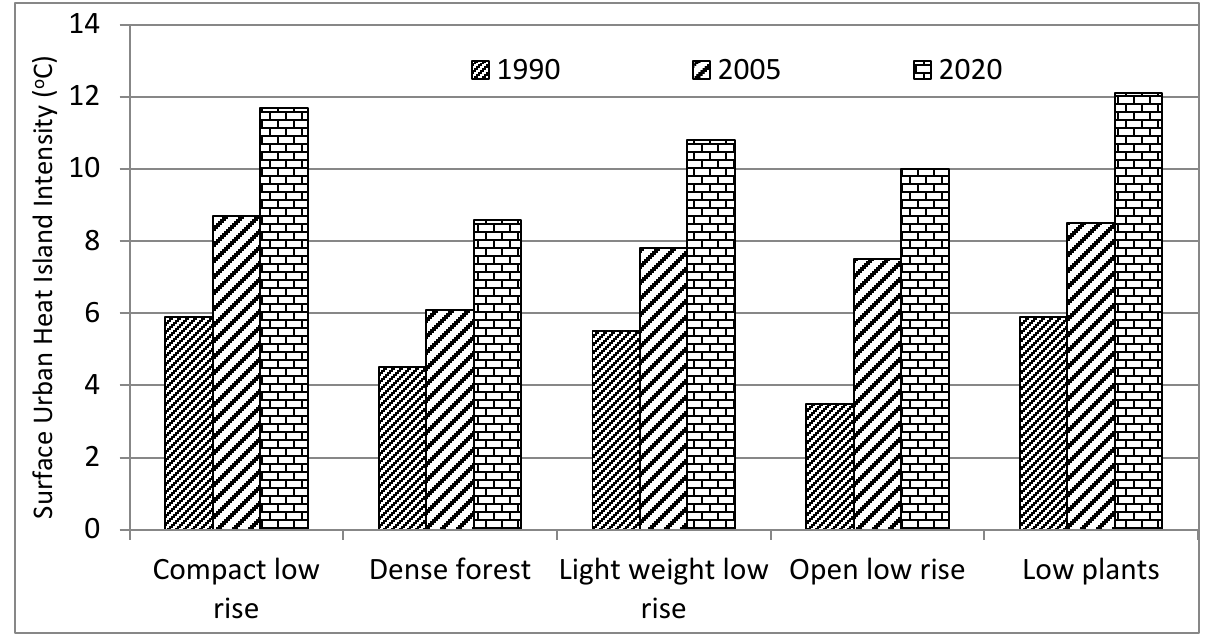
Figure 10. Changes in SUHI intensities across LCZs from 1990 to 2020 in Bulawayo.